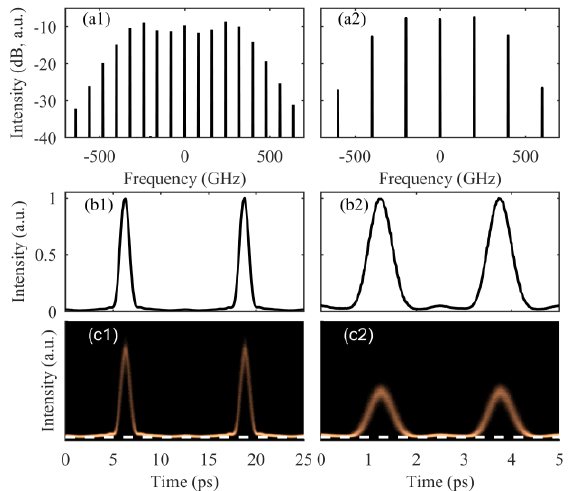
Fig. 3. (a) Spectral and (b) temporal intensity profiles after spectral components cancelation. (c) is the temporal profile recorded in the persistent mode. Panels (1) deal with a repetition rate of 80 GHz whereas panels (2) are obtained at 200 GHz. The white dotted line is the background level of the optical sampling